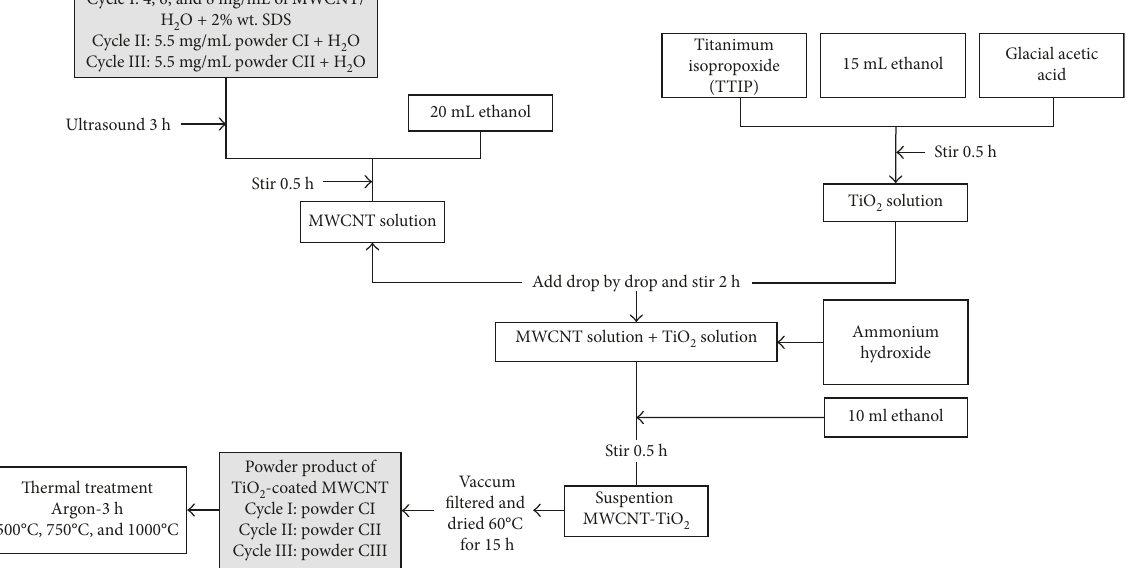
Figure 1: Flowchart describing the carbon nanotube-coating process with TiO